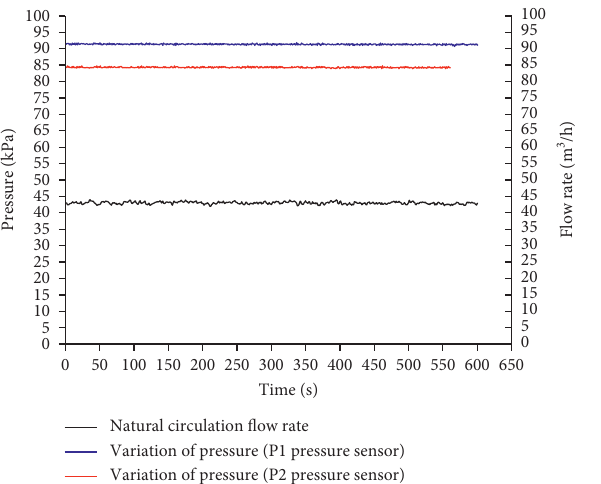
Figure 14: Vibration frequency and amplitude with water level of 8 m.